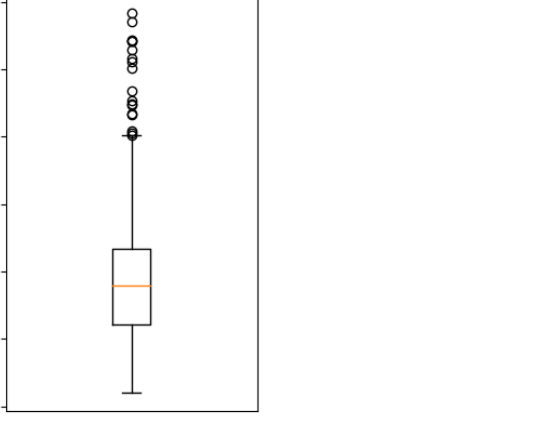
Figure 6. Box and whisker plot of the RMSE between the RWM_SARWS forecasts of RST at the RWS of Stabroek and at close observed road segments (<=500 m) computed for the whole forecast length (2 h). The RMSE box extends from the first to the last quartile, while the orange line corresponds to the median. Each whisker corresponds to a length of maximum 1.5 interquartile range. The time period ranges from 6 May 2021 to 1 December